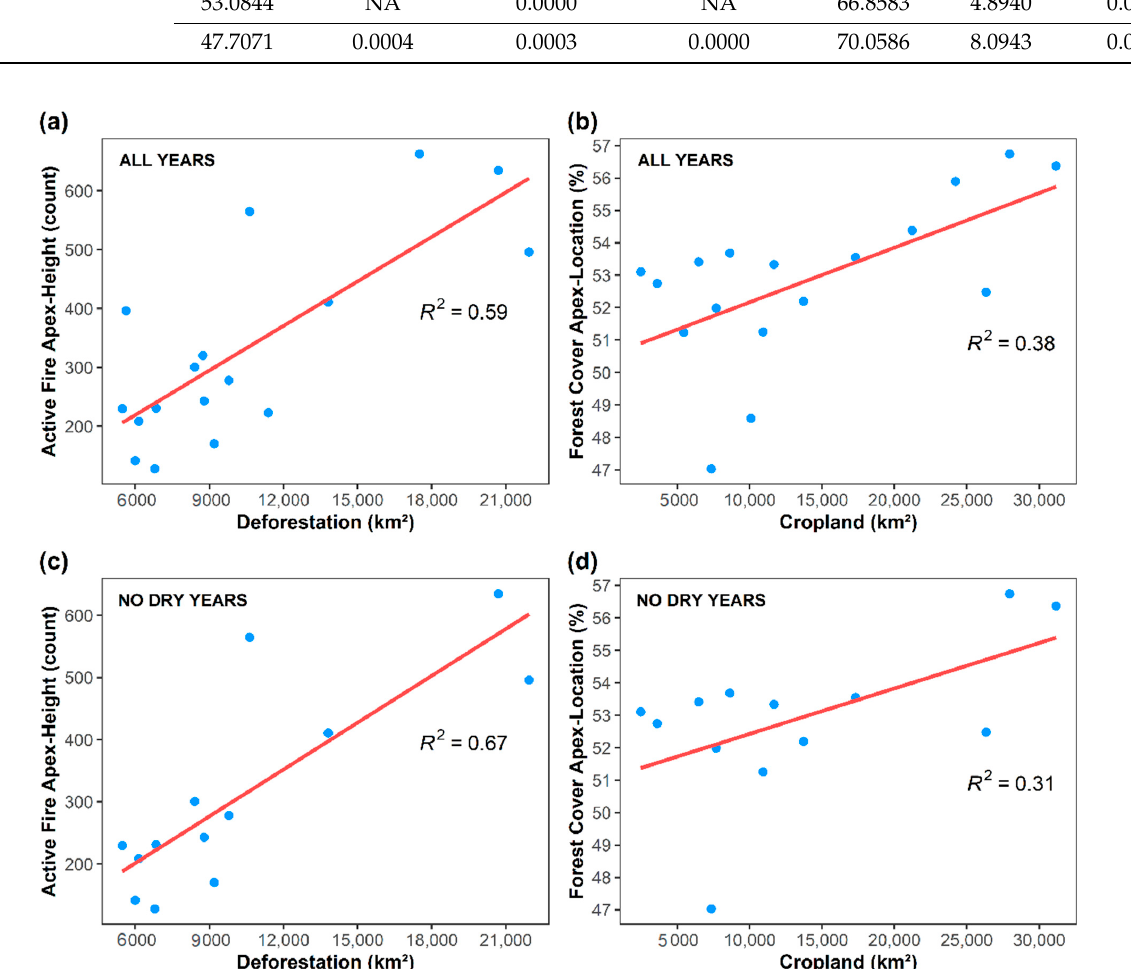
Figure A4. Linear models of the significant variables used to describe active fire apex-height and forest cover apex-location. ( a ) Active fire apex-height by annual deforestation with all years. ( b ) Forest cover apex-location by cropland area over all years. ( c ) Active fire apex-height by annual deforestation without severe drought years. ( d ) Forest cover apex-location by cropland area without severe drought years.